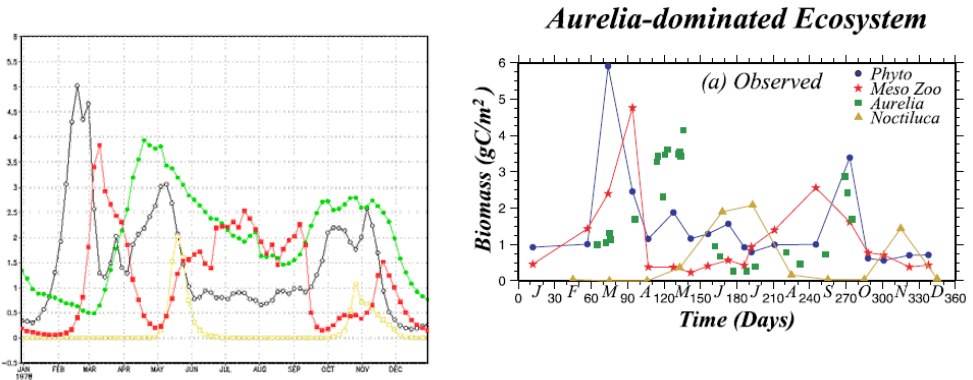
Figure 18 Seasonal cycles of phytoplankton, mesozooplankton, Noctiluca and medusa Aurelia biomasses derived from modelling (left) and in-situ measurements.